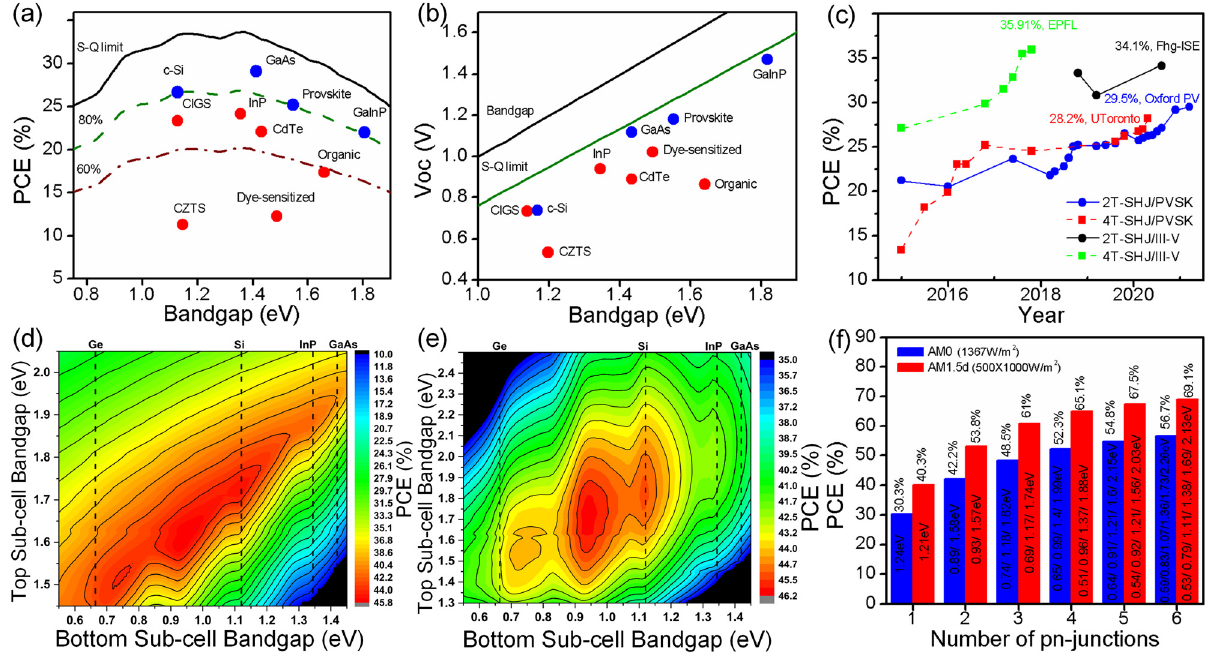
Figure2: (a)TheoreticalShockley – Queisser(SQ)detailed-balanceefficiencylimitforsinglejunctionsolarcellasafunctionofbandgap(solid line). The green and red dashed lines represent 80 and 60% SQ efficiency limit, respectively [34]. The red and blue spheres show the record ef fi ciency of different materials [24]. All data are for standard AM1.5 illumination at 1000 W/m 2 . (b) Open-circuit voltage V oc as a function of bandgapisshownforreference.Theareaindicatedbythetwo-wayarrowisthevoltagegap V g − V SQ [35].Copyright2019,SpringerNature.The redandbluespheresrepresenttherecord V oc ofdifferentmaterials[24].(c)Ef fi ciencyevolutionof siliconheterojunction (SHJ)-based TSCs:2T perovskite/SHJ, 2T III – V/SHJ, 4T perovskite/SHJ, 4T III – V/SHJ. (see Tables 1 – 3 for references). (d) Maximum ef fi ciency contours for dual junction 4T tandems sunder 1 sun AM1.5G [21]. Copyright 2015, IEEE. (e) Maximum ef fi ciency contours for dual junction 2T tandems sunder 1 sunAM1.5G[21].Copyright2015,IEEE.(f)Theoreticalef fi ciencylimitformultijunctionsolarcellscorrespondingto thenumberofpn-junctions. The blue and red bars represent the solar spectrum of AM0 (1367 W/m 2 ) and AM1.5d (500 × 1000 W/m 2 ) [36]. Copyright 2018,